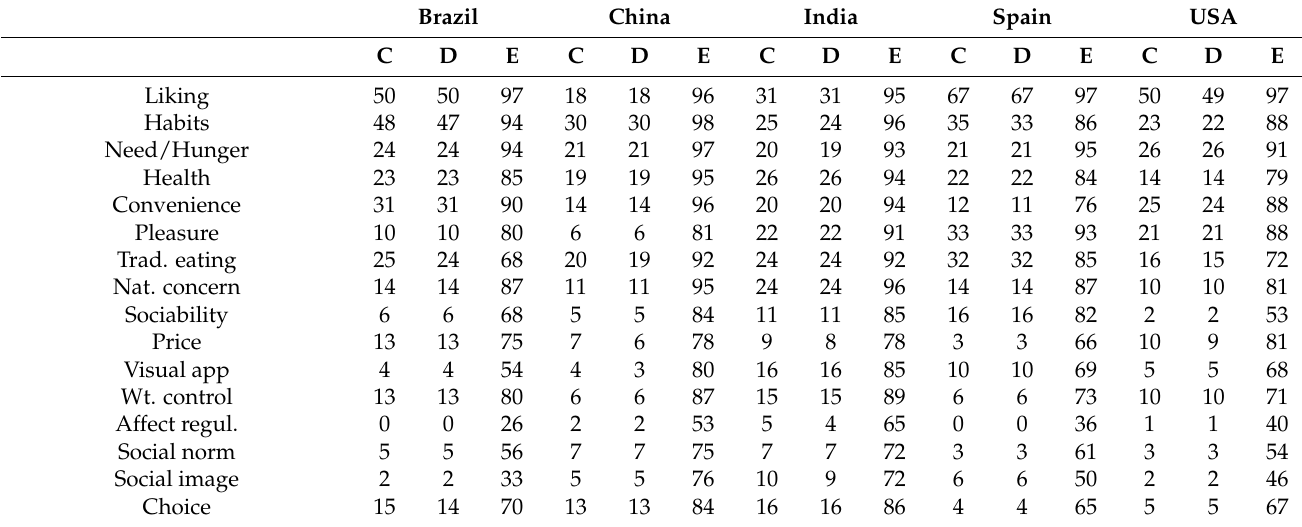
Table 2. Percentage of “apply” responses for CATA, RATA, and RATING for all five countries for the respective starch- rich foods.